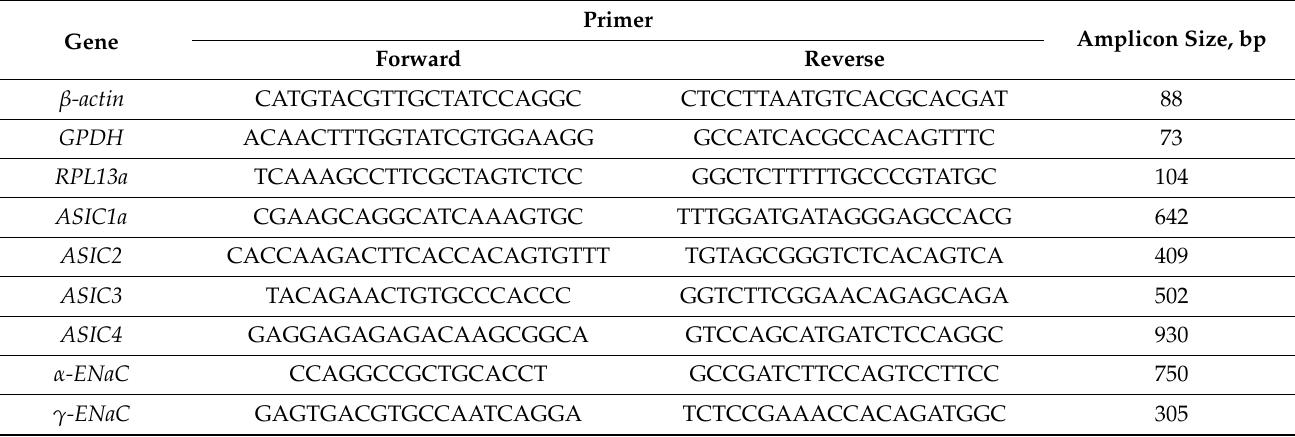
Table 1. Primers, used for qPCR